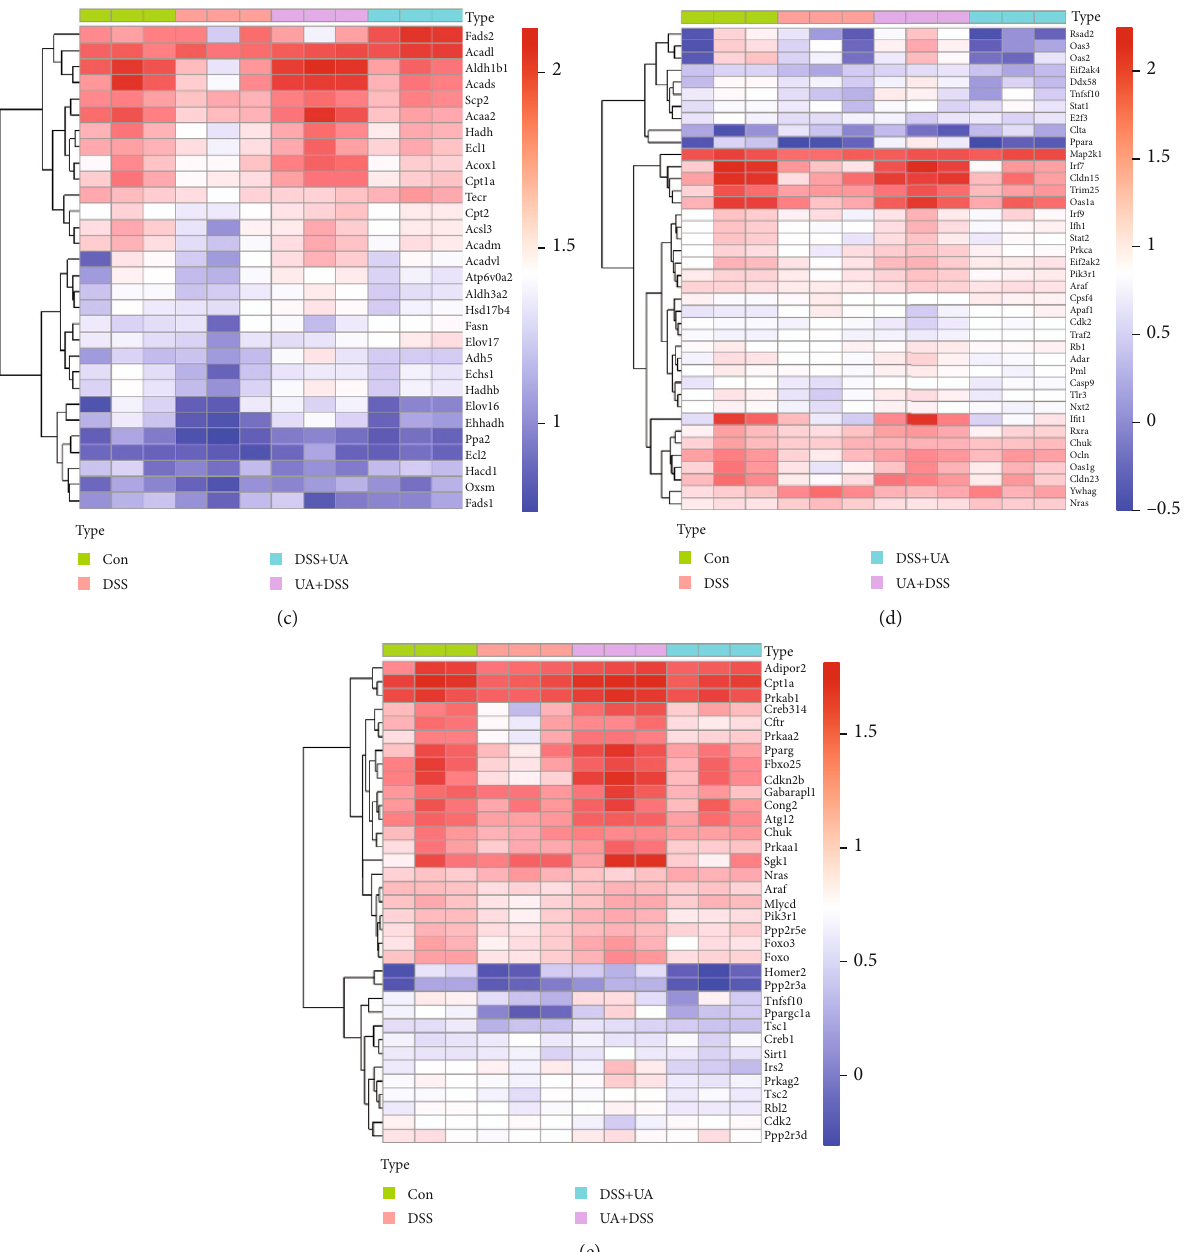
Figure 4: Gene expression modules associated with UA therapy and prevention. (a) The KEGG signaling pathway enrichment results of blue module genes associated with the phenotype of the UA+DSS group. (b) The KEGG signaling pathway enrichment results of red module genes associated with the phenotype of the DSS+ UA group. (c) Heatmap of fatty acid metabolism signaling pathway gene expression. (d) Heatmap of the virus infection signaling pathway gene expression. (e) Heatmap of the AMPK and FoxO signaling pathway gene